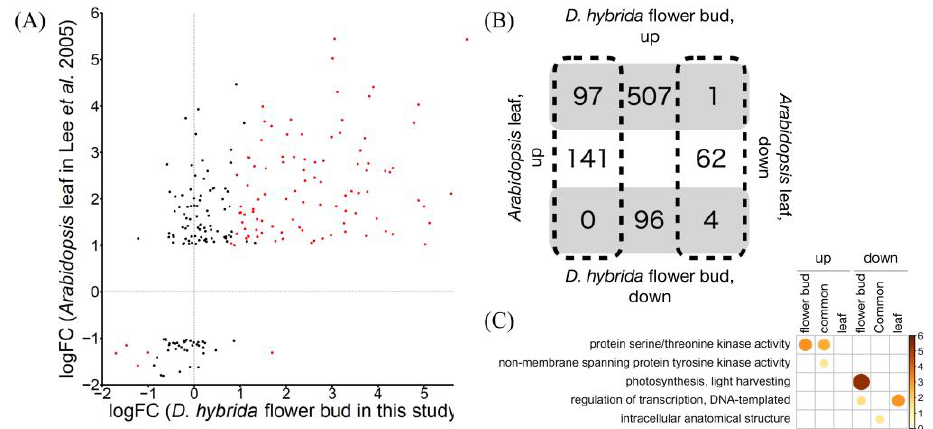
Figure 2. Comparison of transcriptome profile between D. hybrida flower buds in this study and Arabidopsis leaves [20]. ( A ) Pairwise gene expression comparison, red dots indicating DEGs in this study (FDR < 0.001). ( B ) Venn diagram of up- and downregulated genes. ( C ) GO enrichment analysis of common, D. hybrida flower bud-specific, and Arabidopsis leaf-specific